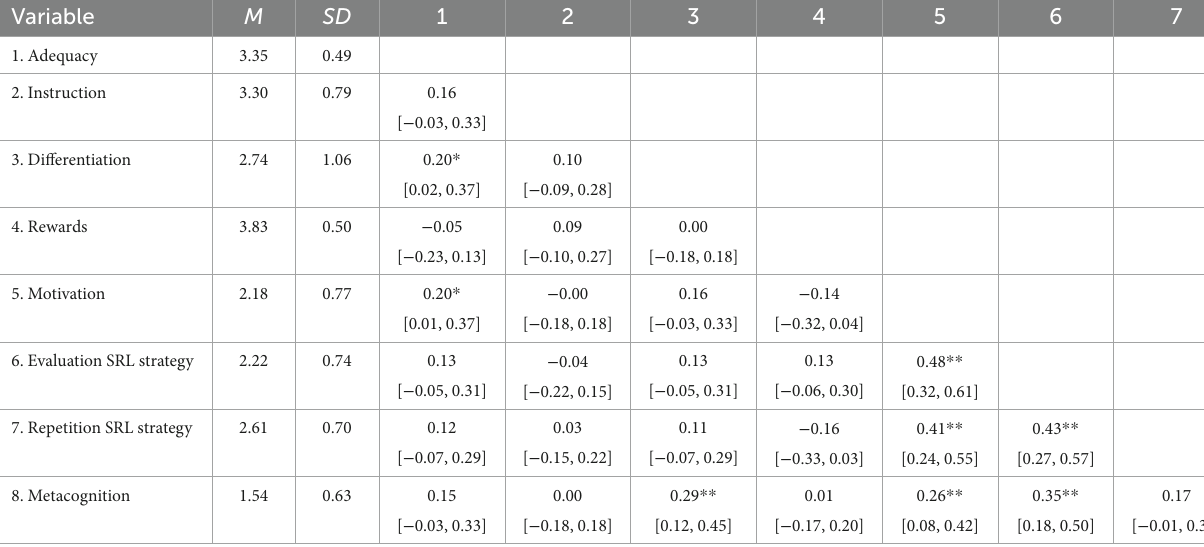
TABLE 3 Means, standard deviations, and correlations with confidence intervals.